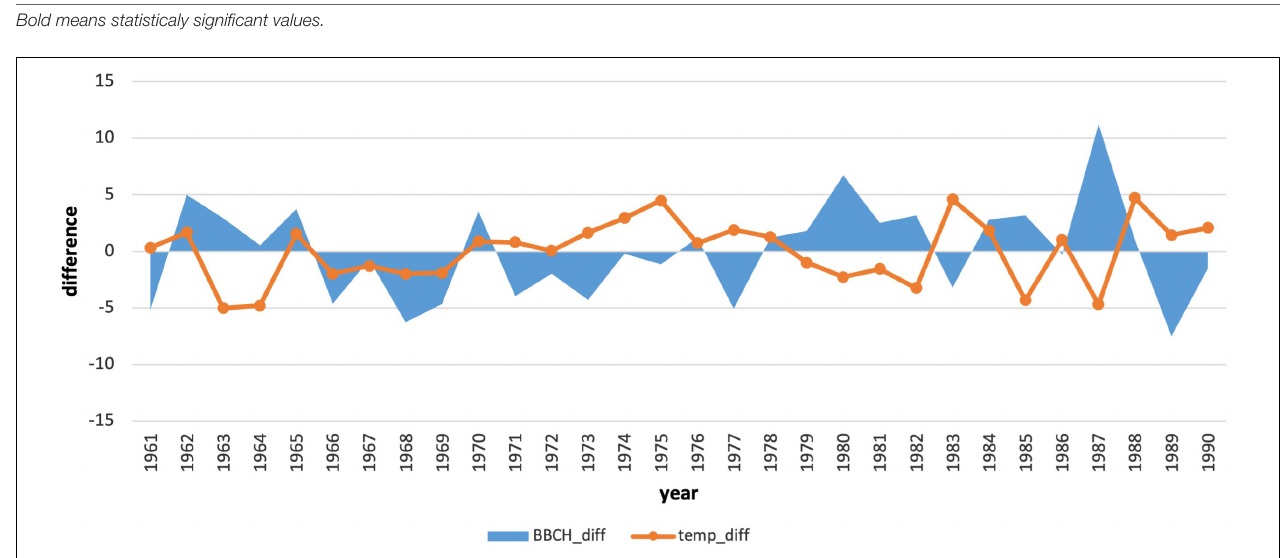
FIGURE 7 | Comparison of deviations of the average monthly air temperatures in January with deviations of the onset of the phenological phase from the long-term average from 1961–1990. the phenological stations in this period reached − 3.14 ◦ C. In total, there were 15 below-average and 15 above-average